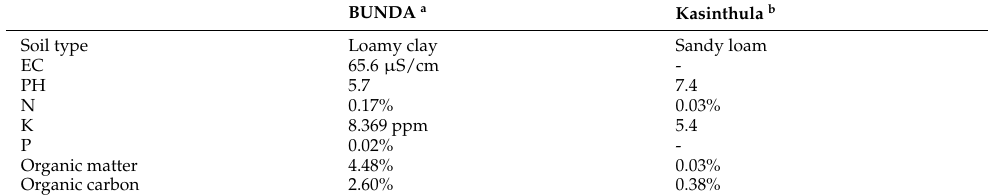
Table 2. Soil physical characteristics of the study sites.